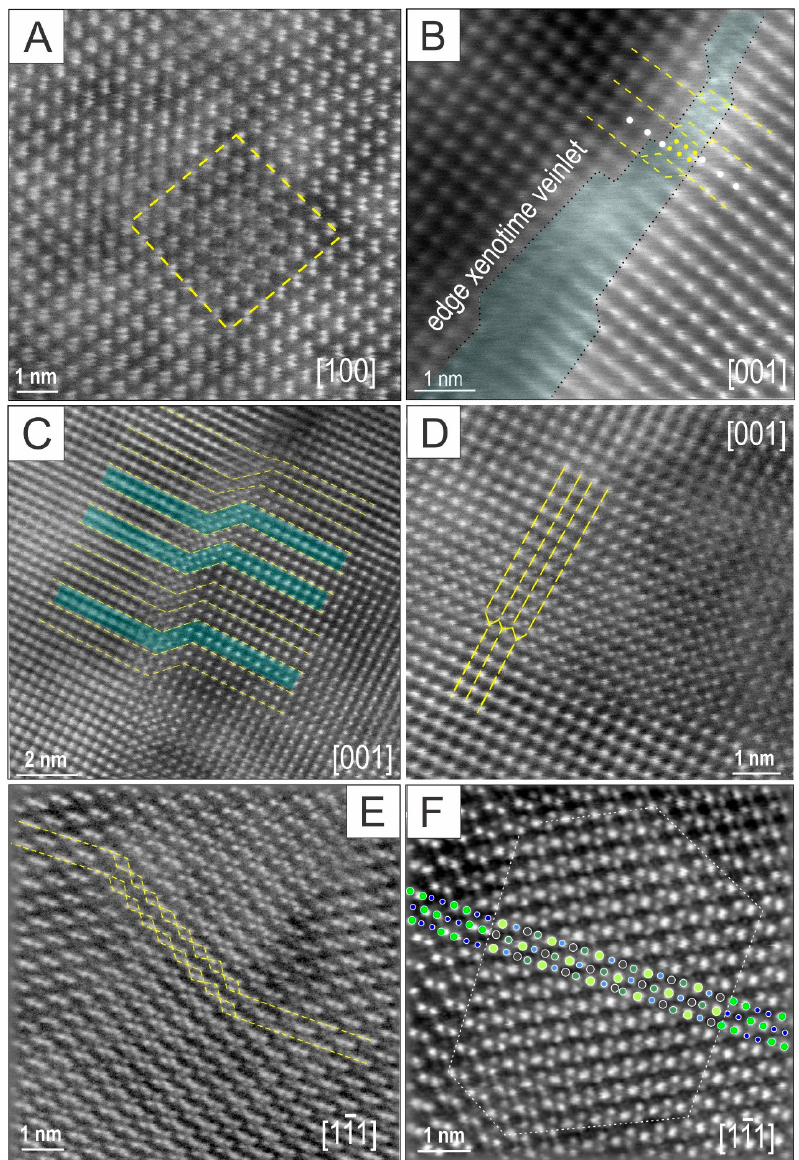
Figure 15. Atomic-scale resolution HAADF STEM images of defects in zircon. ( A ) Square-shaped defect (yellow outline) in U-richer bands from Cape Donington (Foil #7), tilted on the (100) zone axis. The doubling of Zr atoms observed along the c -axis suggests atom “stretching) along b induced by strain, attributable to α -recoil damage during U-decay. ( B ) Simple linear defect in Wirrda Well–Donington zircon (Foil #4) observed at the edge of a xenotime veinlet (blue overlay); sample tilted on the (001) zone axis in zircon. Screw dislocations (dashed lines) are marked by atom loops in the defect plane (yellow dots) relative to Zr atoms (white dots) outside the defect. ( C – D ) Screw dislocations (dashed lines) along a fault or at the edge of a planar defect on the (001) zone axis in Charleston zircon (Foil #6). Note irregular atom loops along the fault plane (blue overlays). ( E – F ) Defects in the Fe-rich, mottled bands from OD distal zircon (Foil #1) with sample tilted on the [11(cid:3364)1] zone axis in zircon. Antiphase atom displacement (dashed line) suggesting lattice stretching along (011) directions in ( E ). ( F ) Details of the defect (dotted line) in Figure 14D showing the size and intensity modifications in Zr and Si atoms along the (011) direction (colors as in Figure 14E). The image shows the inferred missing Si atoms as dark, regular spots along this direction.